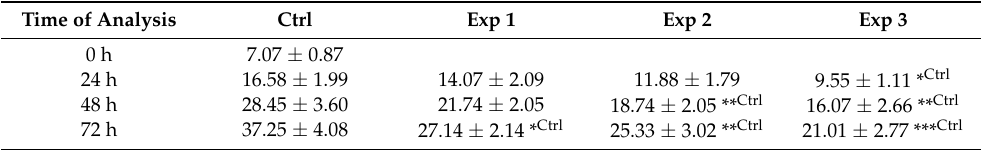
Table 7. Reactive oxygen species production by boar spermatozoa (RLU/s/10 6 cells) exposed to selected semen extenders during different time intervals.